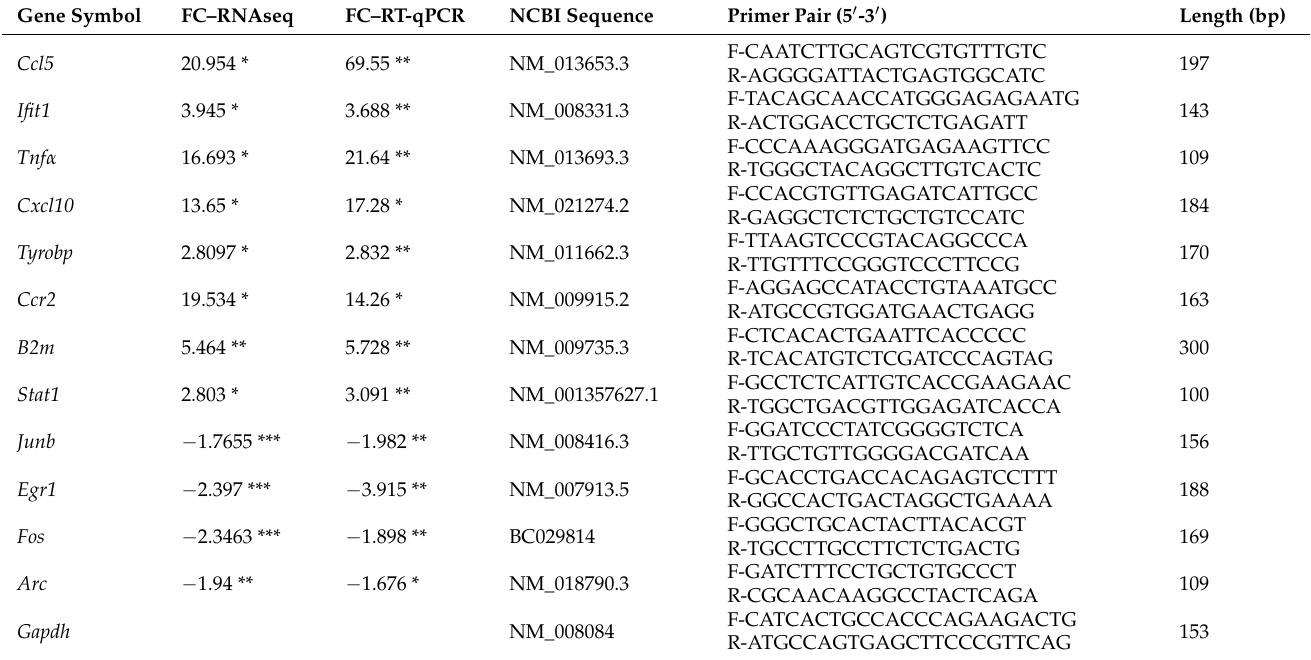
Table 1. Summary of RNA sequencing results for selected differentially expressed genes (DEGs) for RT-qPCR